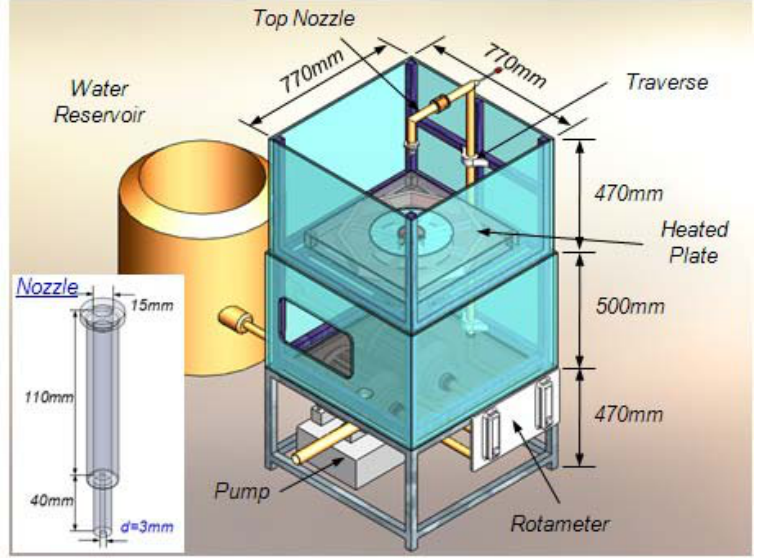
Fig. 1 Schematics of experimental